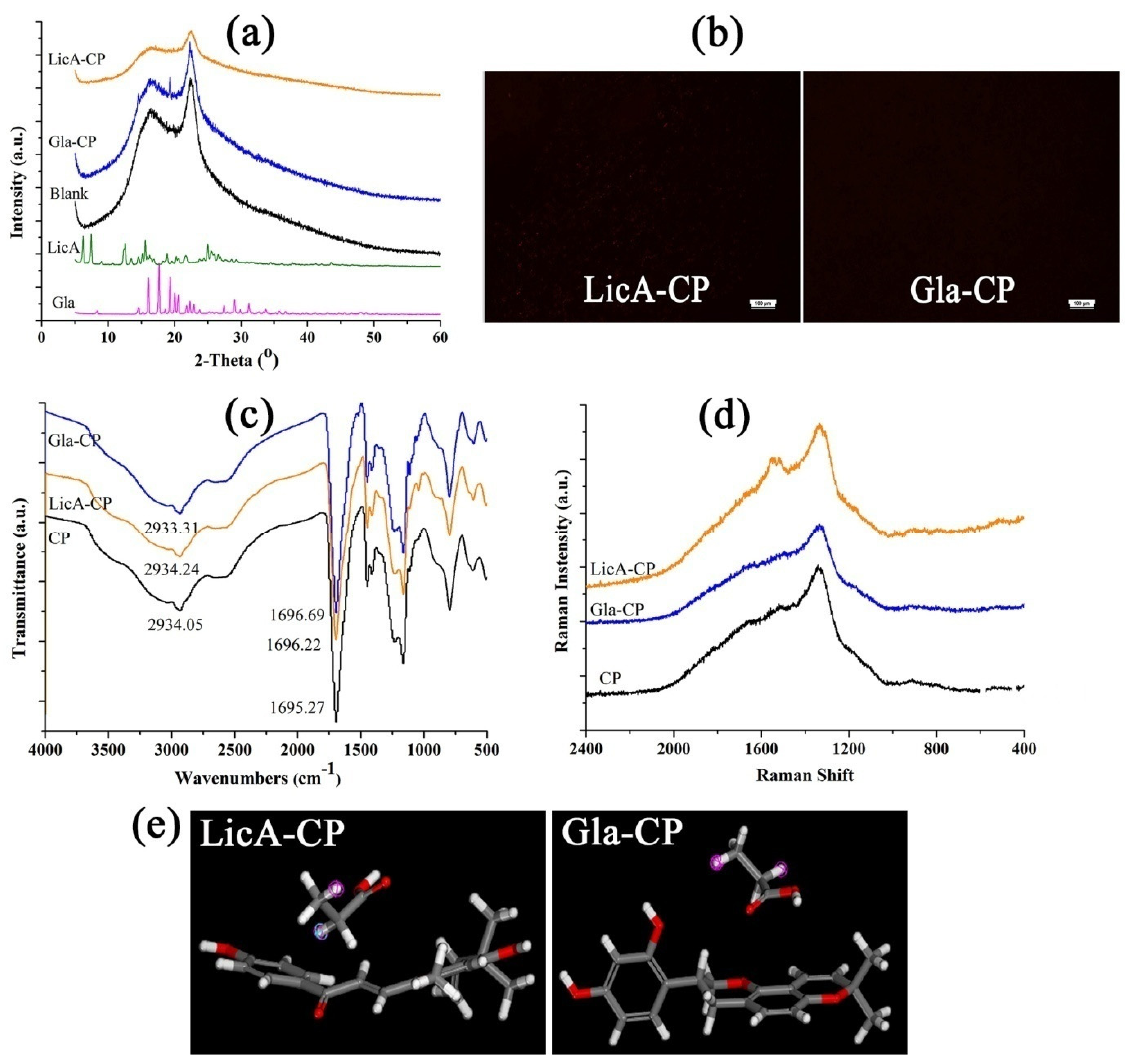
Figure 2. ( a ) X-ray powder diffractograms of different hydrogels; ( b ) PLM images of CP films; ( c ) FT-IR spectra of CP, LicA–CP, and Gla–CP; ( d ) Raman spectra of the hydrogels; ( e ) conformations of LicA-CP and Gla-CP.